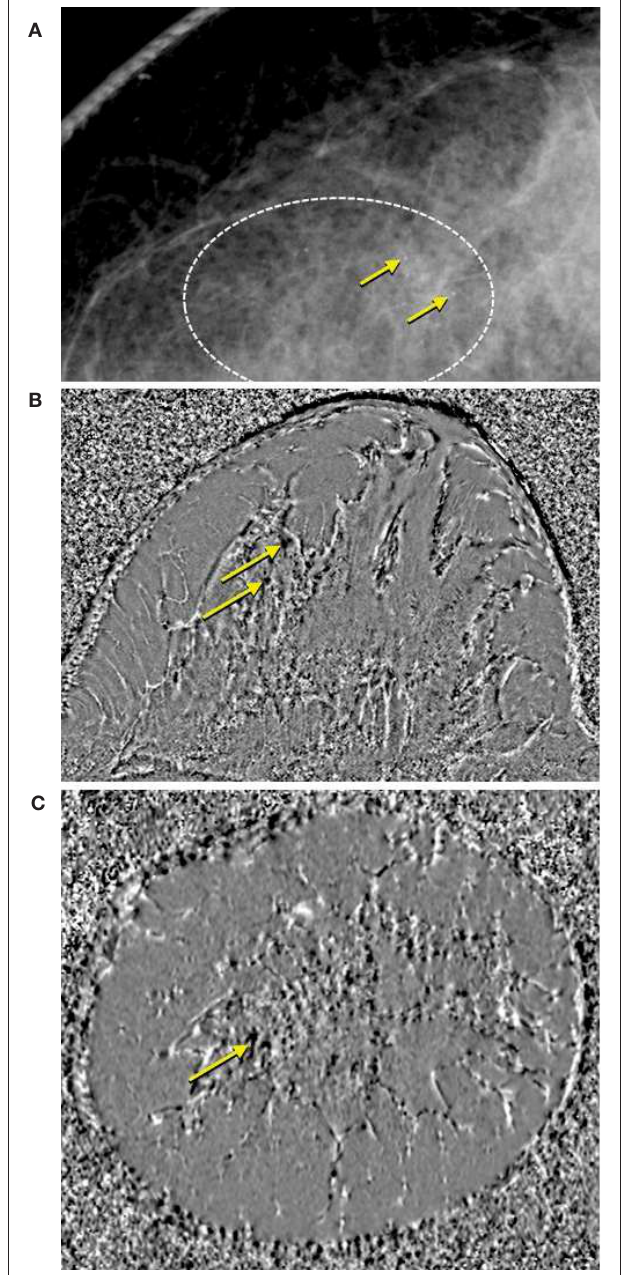
FIGURE 6 | Comparison of (A) mammogram and (B,C) susceptibility weighted phase images acquired at 7T with a 0.35-mm isotropic resolution T * 2 -weighted 3D gradient echo sequence (105). Diamagnetic microcalcifications are indicated by yellow arrows and are hypointense in the susceptibility weighted phase